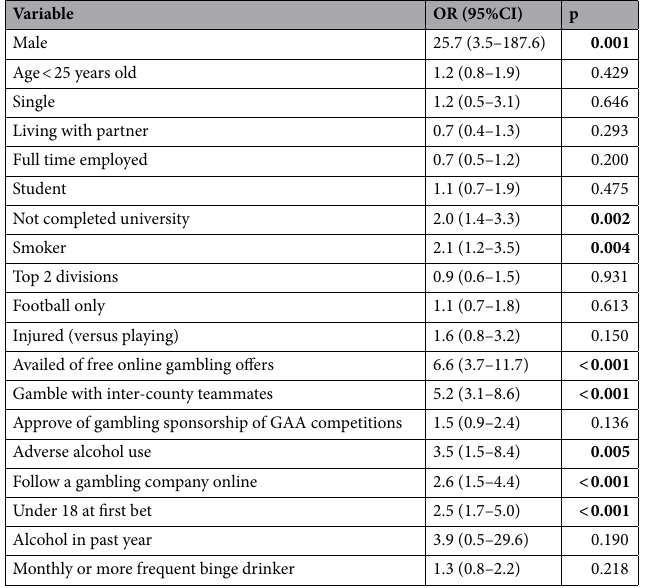
Table 6. Univariate analysis for moderate/high risk gambling (PGSI ≥ 3). Significant values are in bold.